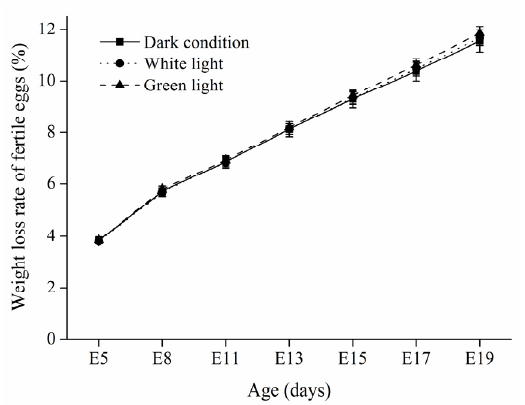
Figure 1. Weight loss rate of fertile eggs (%) on embryonic days 5, 8, 11, 13, 15, 17, and 19 (E5, E8, E11, E13, E15, E17, and E19) incubated under light-emitting diodes–based white light, green light or dark condition. Values are presented as means±standard error (n = 12).